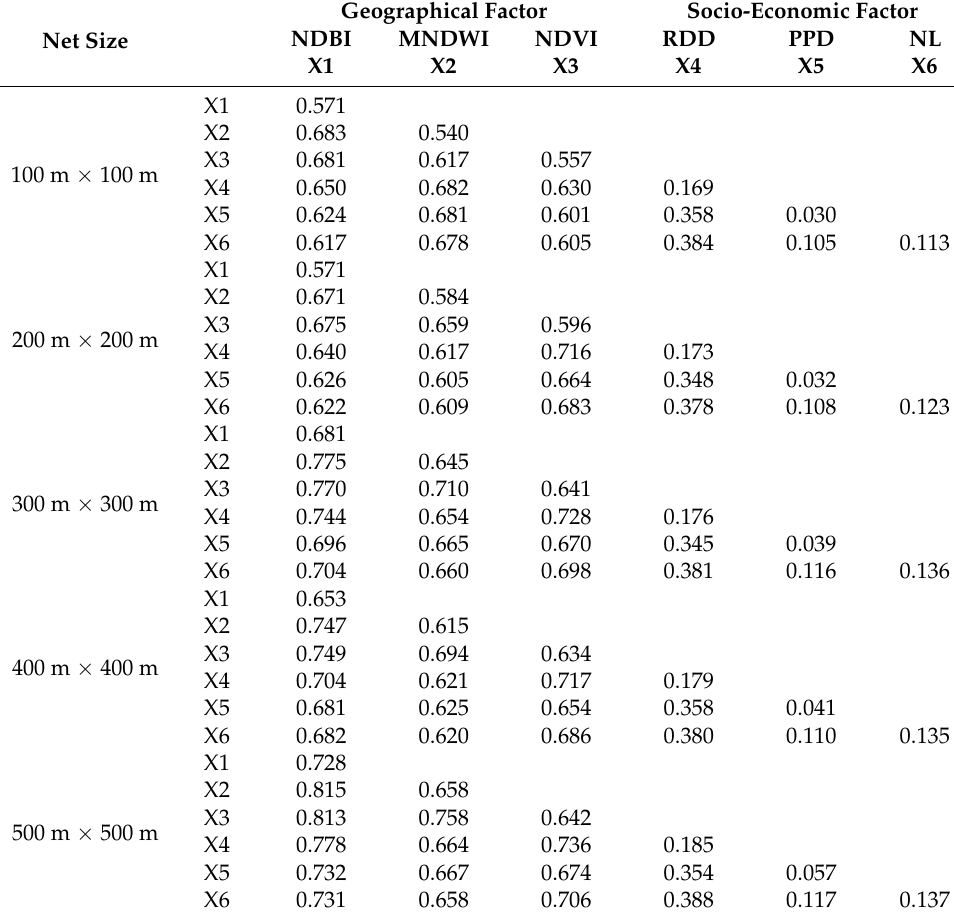
Table A2. Optimal scale detection of factor